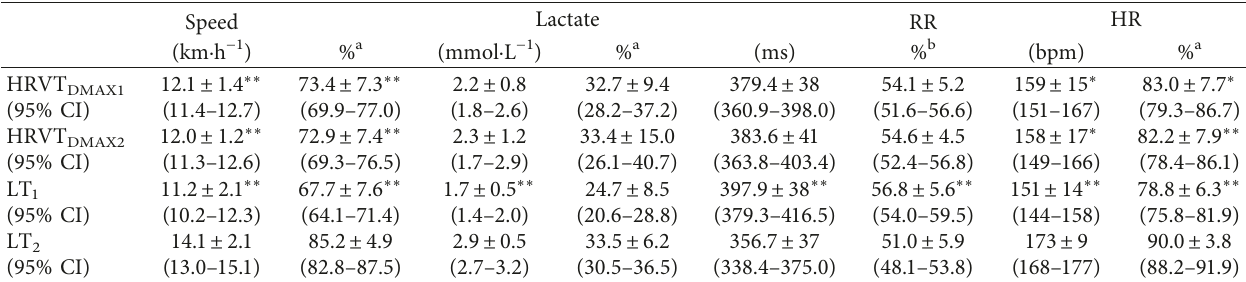
a Percentage valuesarerelativetomaximal valuesduring theMIRT. b Percentage valuesarerelativeto5km · h − 1 values (RR);CI � confidence interval. ∗∗ p < 0 . 01 and ∗ p < 0 . 05 in relation to LT 2 method. Table 2: Pearson correlation expressed as absolute and relative values for speed, blood lactate, RR interval, and heart rate during maximal running test among well-trained